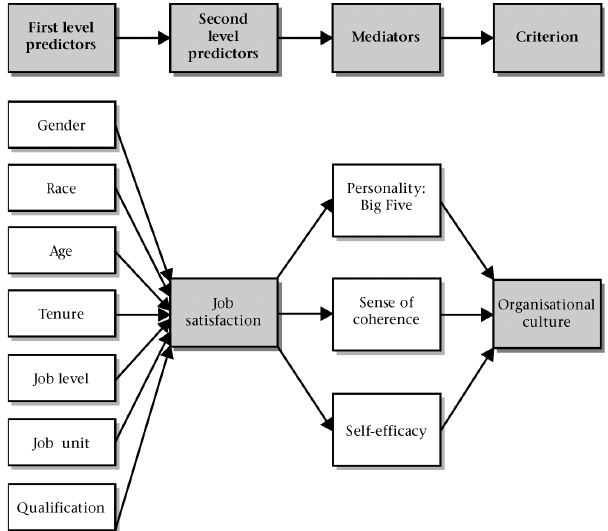
Figure 1: Prediction model of perceived